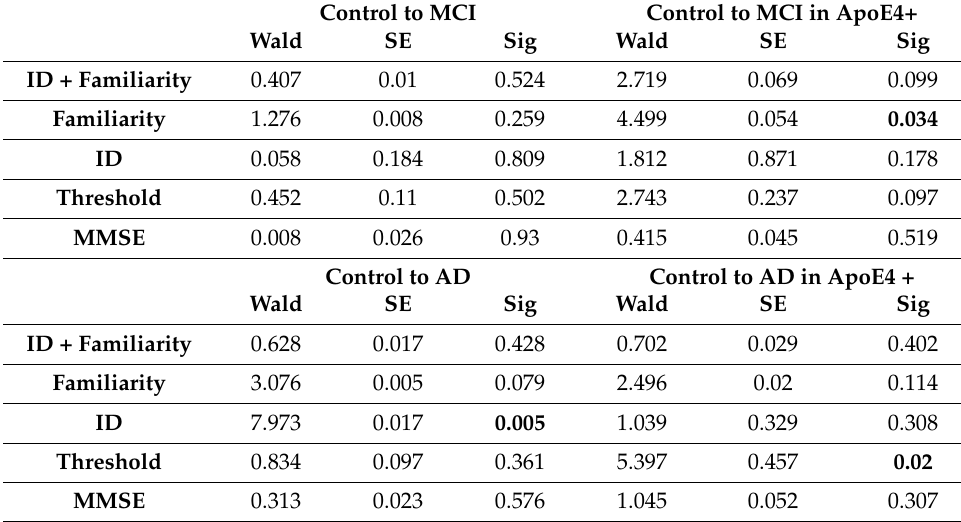
Table 5. Logistic regression: odor measures and